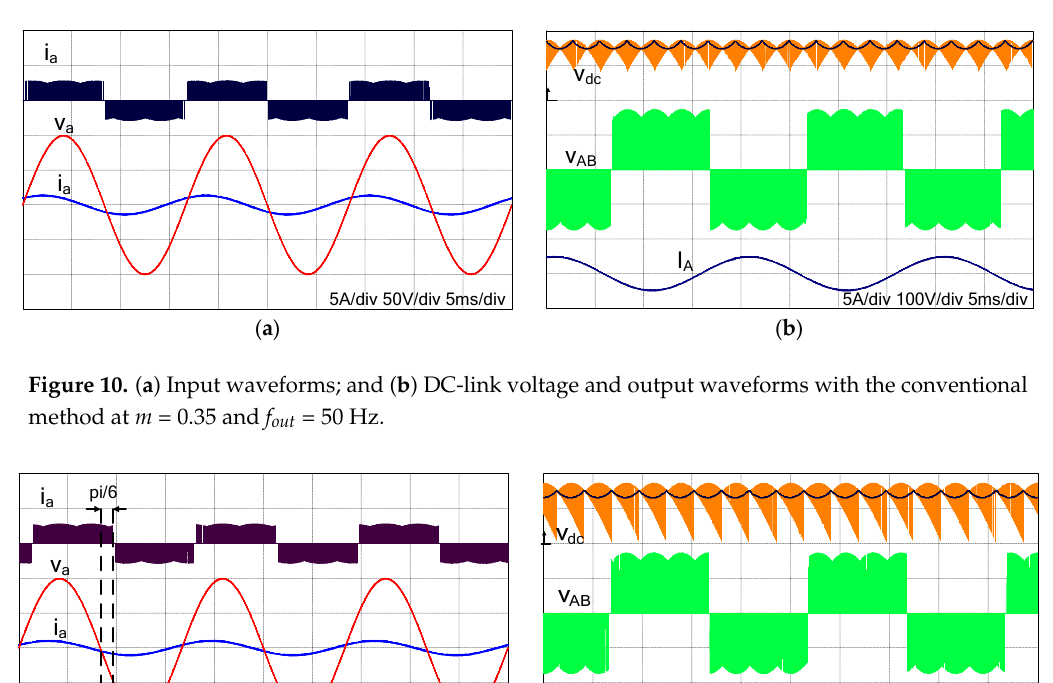
Figure 12. Experimental setup for the IMC topology.